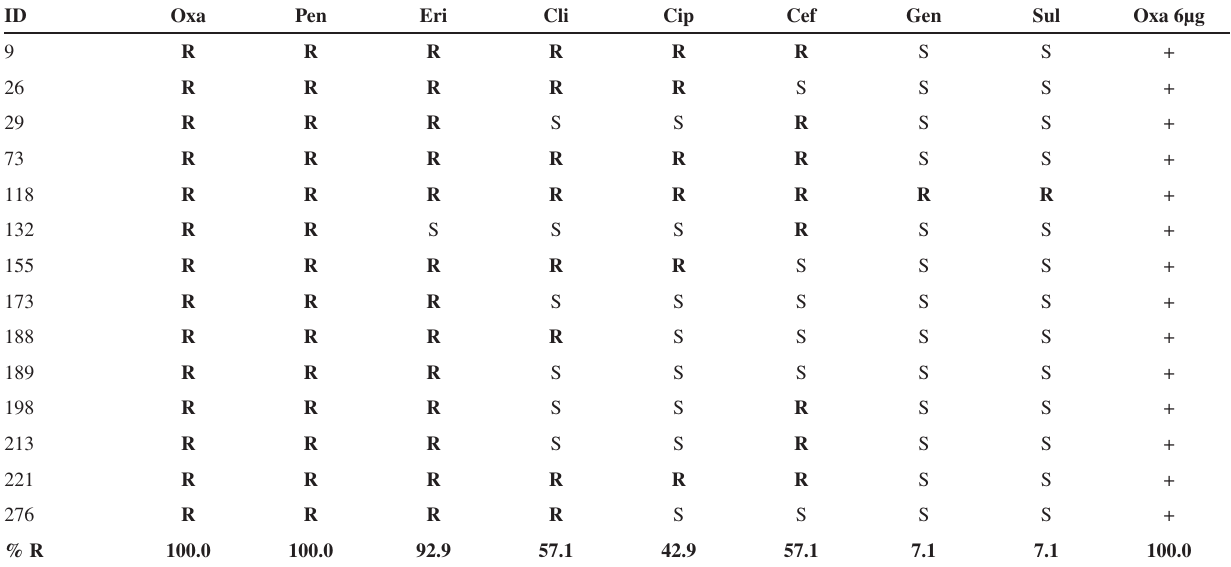
Table 5 - Antimicrobial susceptibility profile detected by disk diffusion test for 14 MRSA-identified health professionals from a public education hospital,